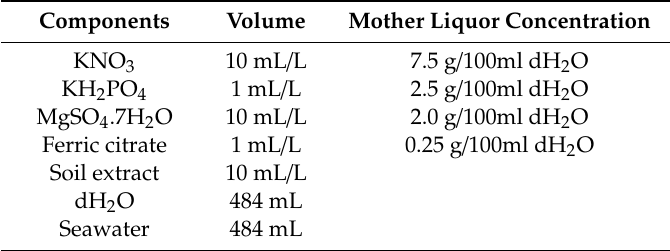
Table 1. Kock medium.